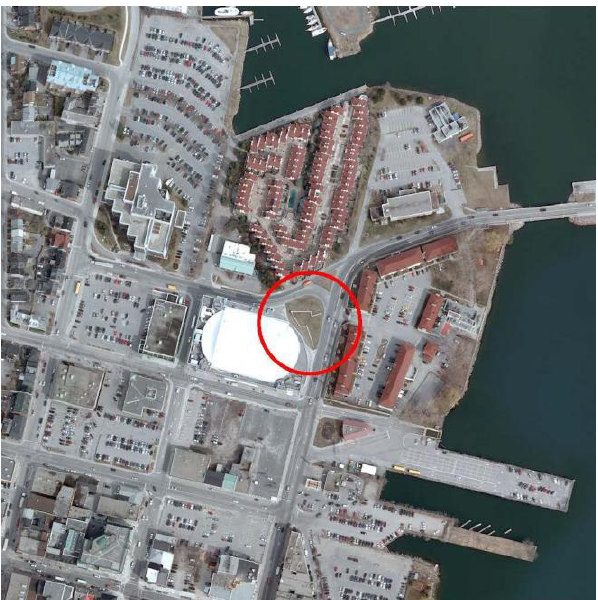
Figure 1. Aerial imagery of surroundings around the remnants of Fort Frontenac © The City of Kingston Copyright 2011.